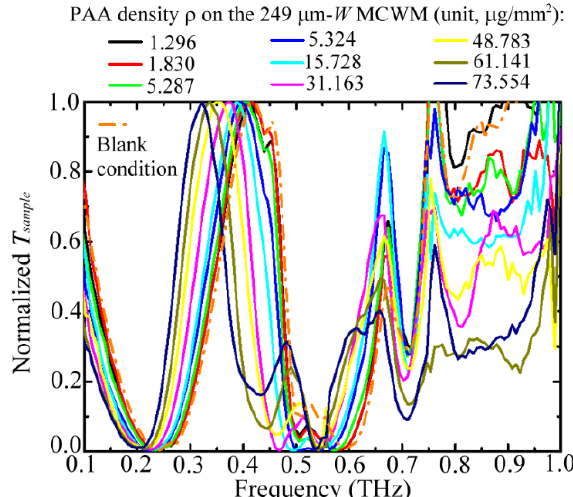
Figure 4. Normalized transmittance of a 249 μ m W MCWM loaded with different weight densities of PAA membranes for thickness detection experiment.